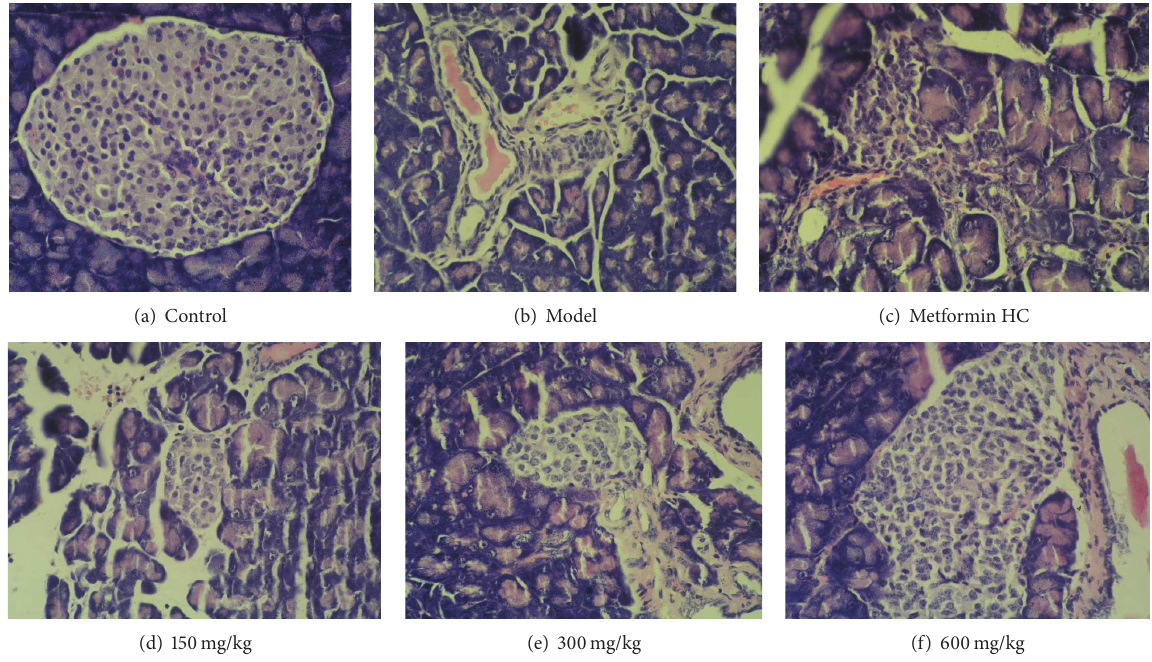
Figure 3: The effect of PEP on the histopathological structure of the pancreas in DM rats (H&E staining). A DM model was established by feeding rats a high-fat diet and injecting them with a low dose of STZ. After the model was established, PEP (0, 150, 300, and 600 mg/kg) was administered intragastrically as an intervention for 28 d ( 𝑛 = 10 rats). The pancreatic tissues were collected, embedded, sectioned, and stained with H&E. (a) control: control group; (b) model: model group; (c) metformin HC: metformin HC group; (d) 150 mg/kg: low-dose PEP group; (e) 300 mg/kg: medium-dose PEP group; (f) 600mg/kg: high-dose PEP group.